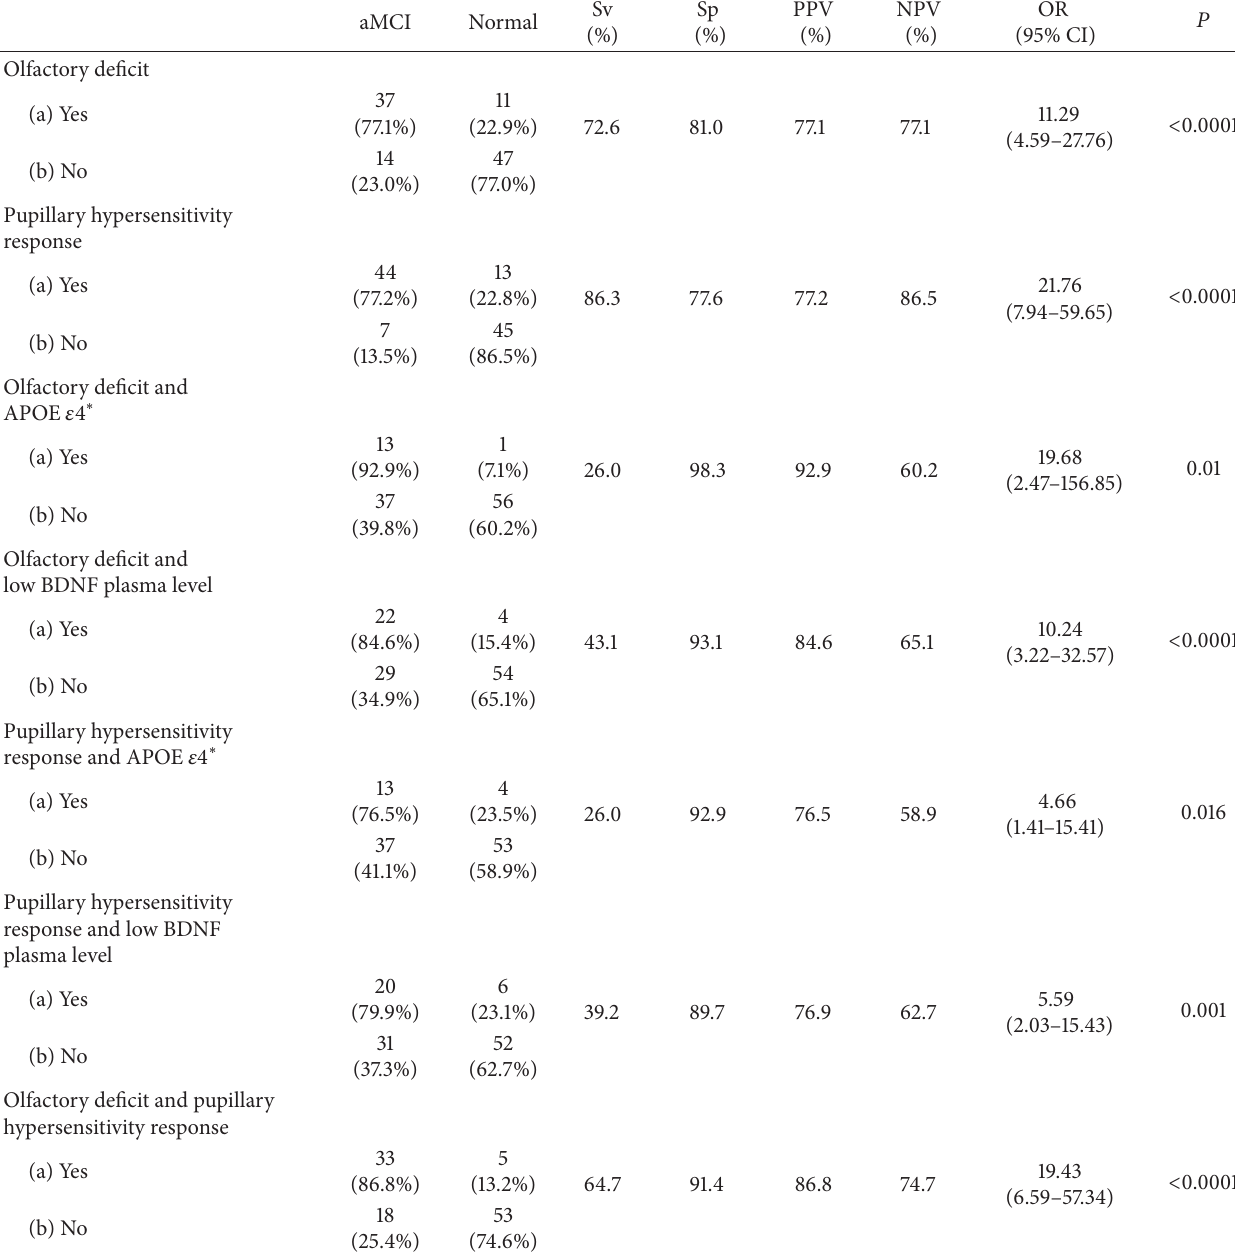
Table 3: Combination of olfactory deficit, pupillary hypersensitivity response, APOE 𝜀4 , and BDNF plasma level in elderly with aMCI and normal